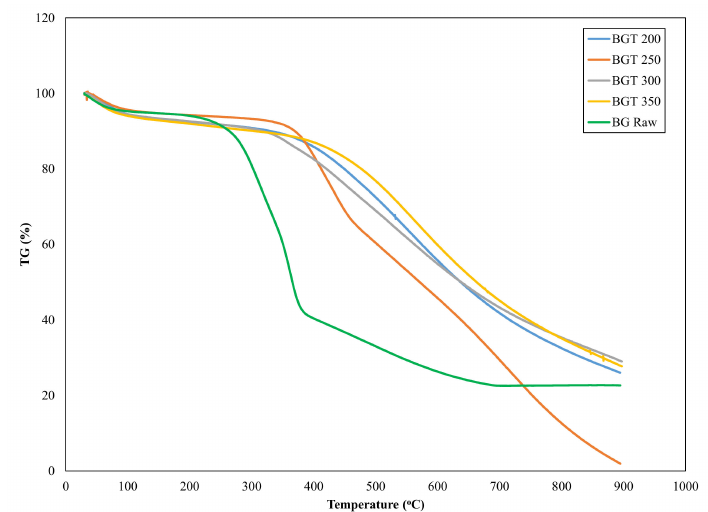
Figure 2. TG curves for raw and torrefied sugarcane bagasse at heating 25 ◦ C/min (BGT200— bagasse torrefied at 200 ◦ C, BGT250—bagasse torrefied at 250 ◦ C, BGT300—bagasse torrefied at 300 ◦ C, BGT350—bagasse torrefied at 350 ◦ C, and BG Raw—raw